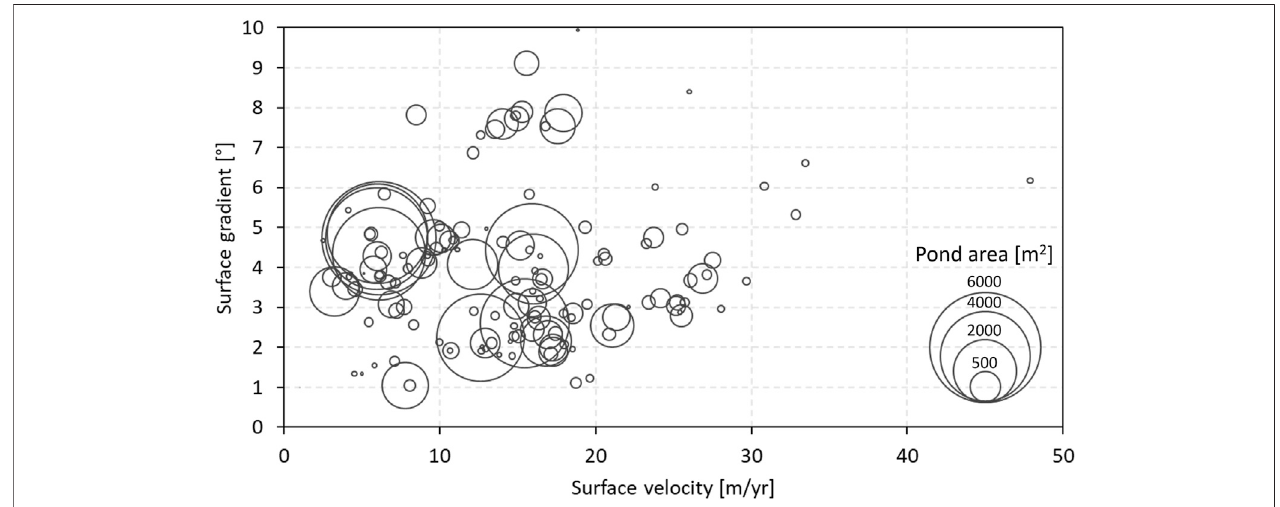
FIGURE 8 | Pond area as a function of surface gradient and interpolated velocity (derived form the spline method). Pond area is proportional to circles size.